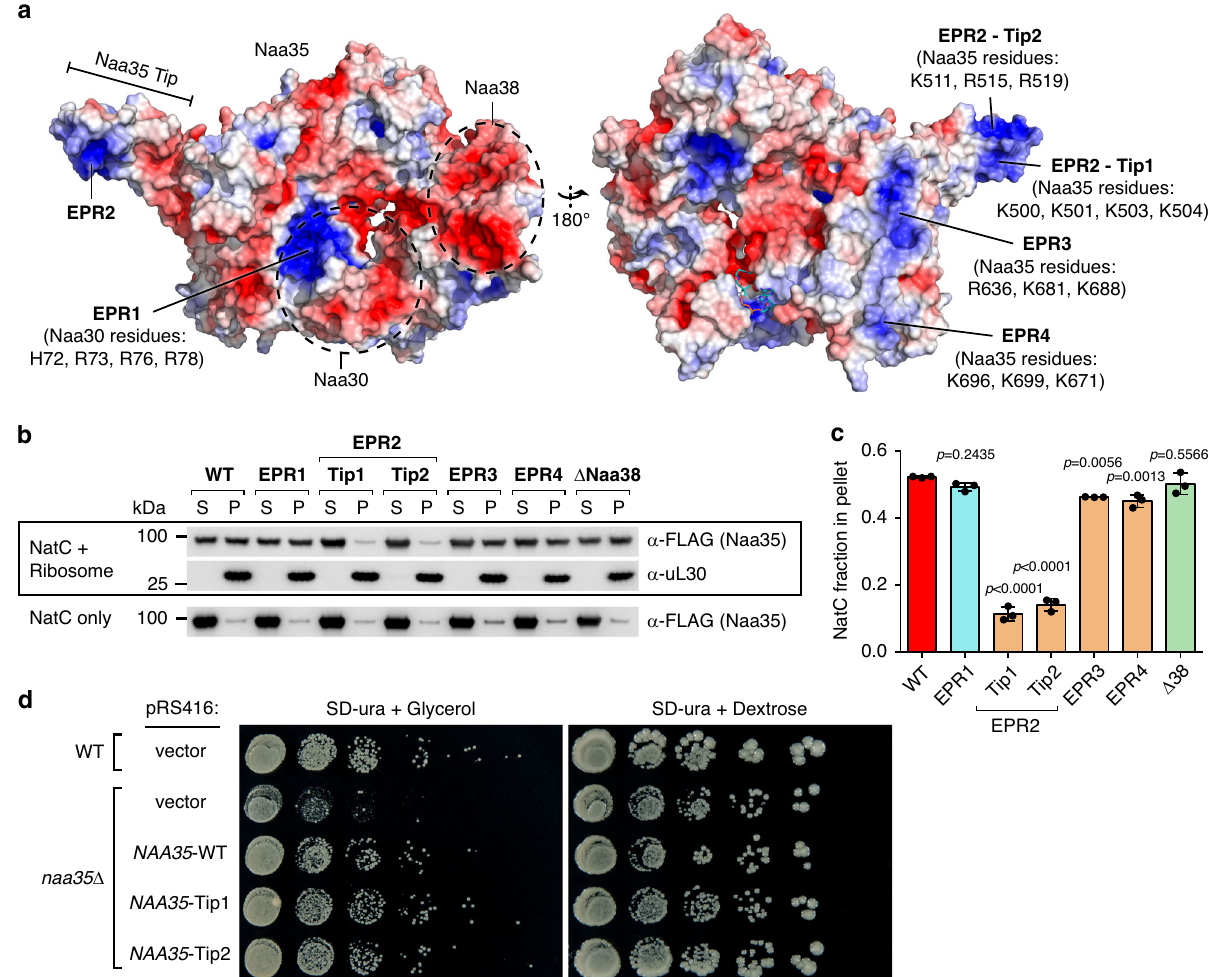
Fig. 5 NatC – ribosome interaction. a Electrostatic surface potential projected on the surface of the NatC • CoA structure. Residues within electropositive regions (EPRs) that were substituted with alanine in NatC mutants constructs are speci fi ed in brackets. b Representative western blot of a NatC/ribosome co-sedimentation assay. NatC constructs in the supernatant (S) and pellet (P) fractions were immunodetected via a FLAG-tag at the Naa35 N-terminus, yeast ribosomes via the ribosomal protein uL30. Co-sedimentations assays were performed in triplicate (all replicates are shown in Supplementary Fig. 11). c Quanti fi cation (chemoluminescence band intensities) of the NatC fraction in the pellet (P/(S + P)). Data represent mean ± SD ( n = 3 independent experiments). NatC mutants were compared against NatC WT using a one-way ANOVA analysis with Dunnetts correction. d Serial tenfold dilutions of S. cerevisiae WT (BY4741) and naa35 Δ (Y00294) strains, transformed with a pRS416 yeast centromere vector, carrying no insert (vector), NAA35 -WT or the NAA35 -Tip1 or NAA35 -Tip2 mutant genes. Cells were grown at 37 °C for 5 days on SD-ura agar plates, supplemented with 3% glycerol or 2% dextrose,